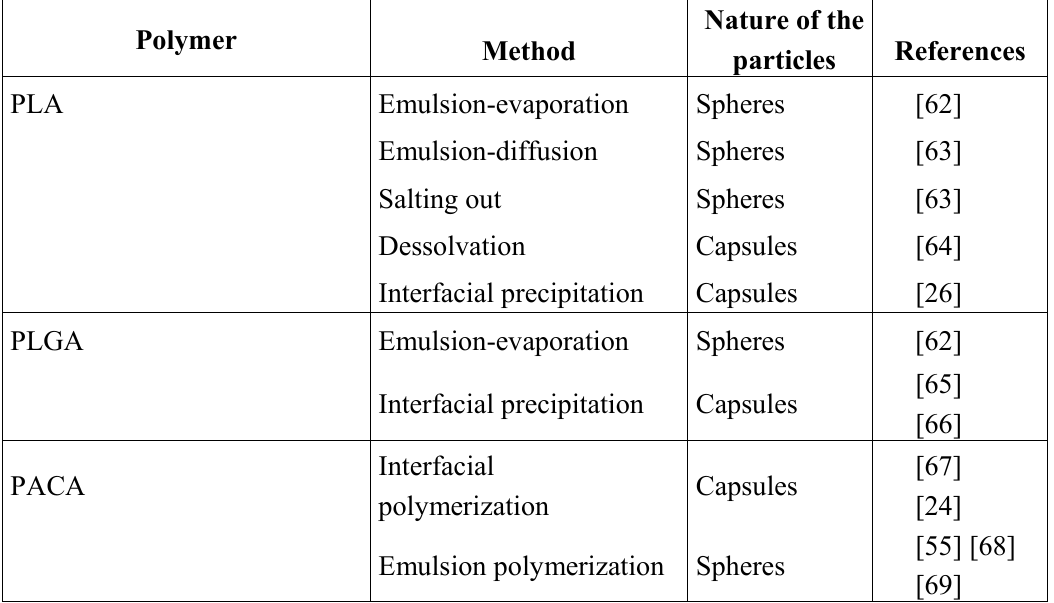
Table 1: Nature of the polymers and preparation methods for polymeric particles intended for oral